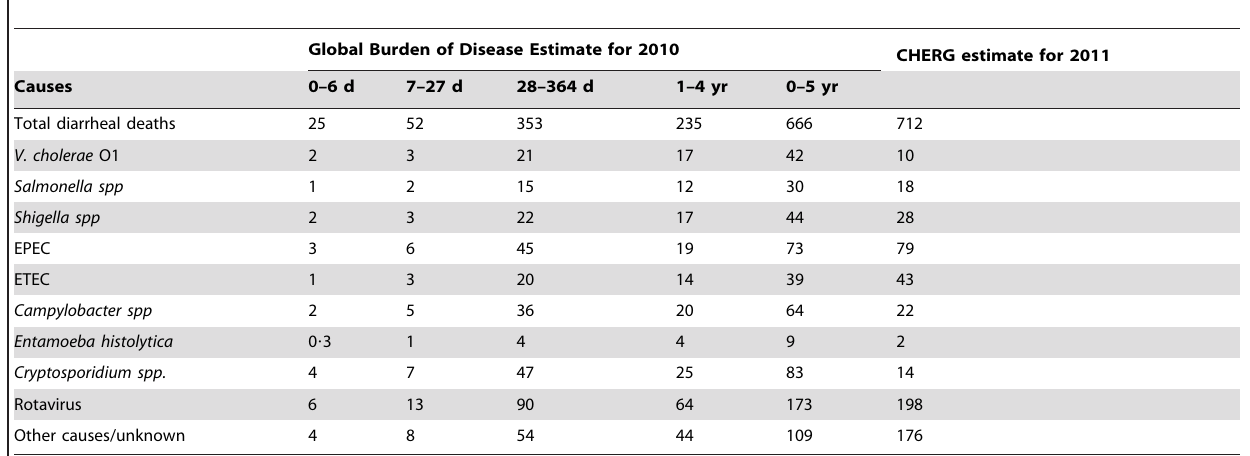
Table 6. Comparison between Global Burden of Diseases (for 2010) and the Child Epidemiology Reference Group (for 2011) estimates of the number of diarrhea deaths ( 6 1000), by cause and age, in children , 5 years of age in the